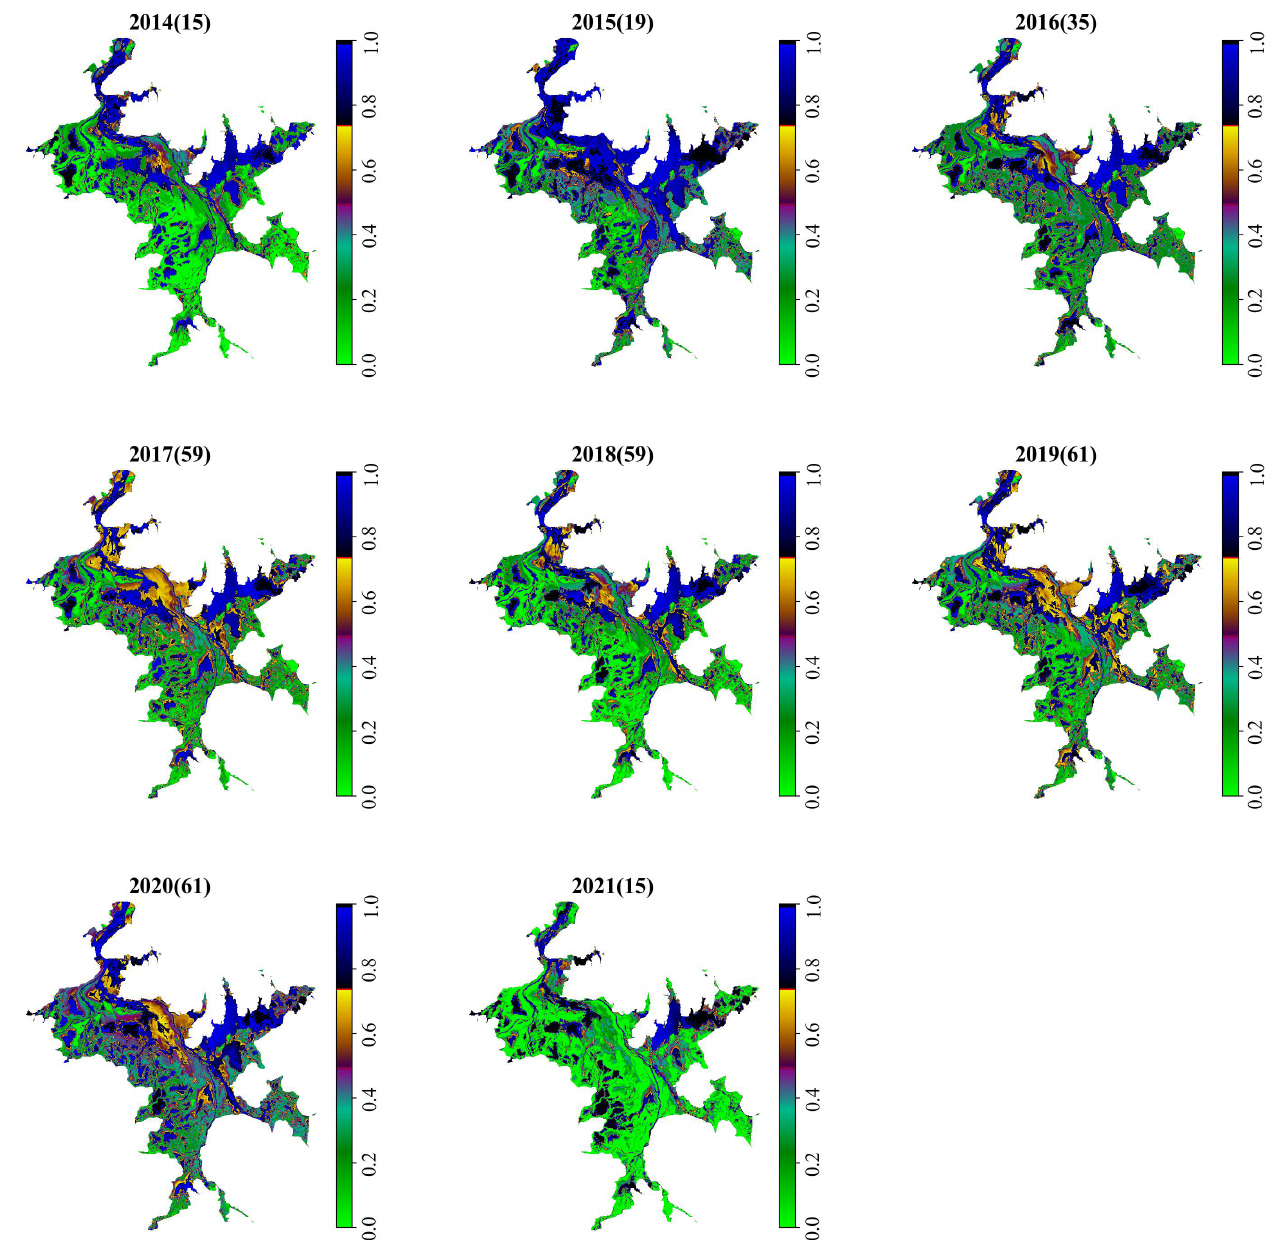
Figure 13. The IF distribution maps for different years from 2014 to 2021. The numbers in the brackets are for the observation times in that